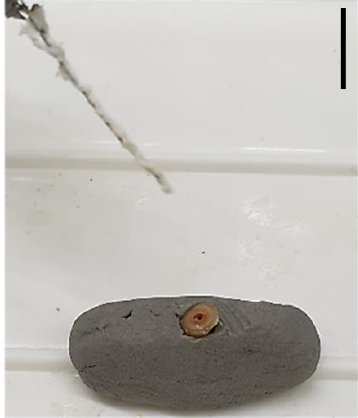
Figure 3. Obturation procedure for extracted human teeth. The roots were placed in modeling clay, the CaP precursor was added into the canal using a syringe and the BDD-electrode was applied. Scale bar: 1 cm.